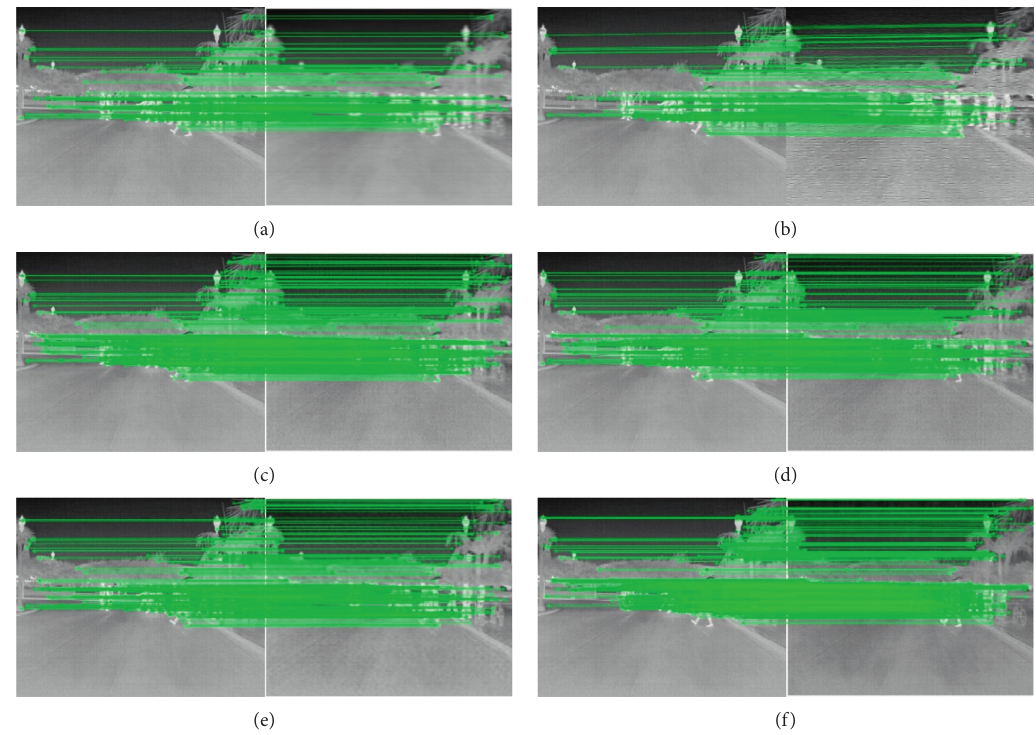
Figure 10: Deblurring image matching results (the images on the left are real and clear images). (a) Blurred image matching result. (b) DeepDeblur method deblurred image matching result. (c) DeblurGAN method deblurred image matching result. (d) CycleGAN method deblurred image matching result. (e) Cycle-Dehaze method deblurred image matching result. (f) Our method deblurred image matching